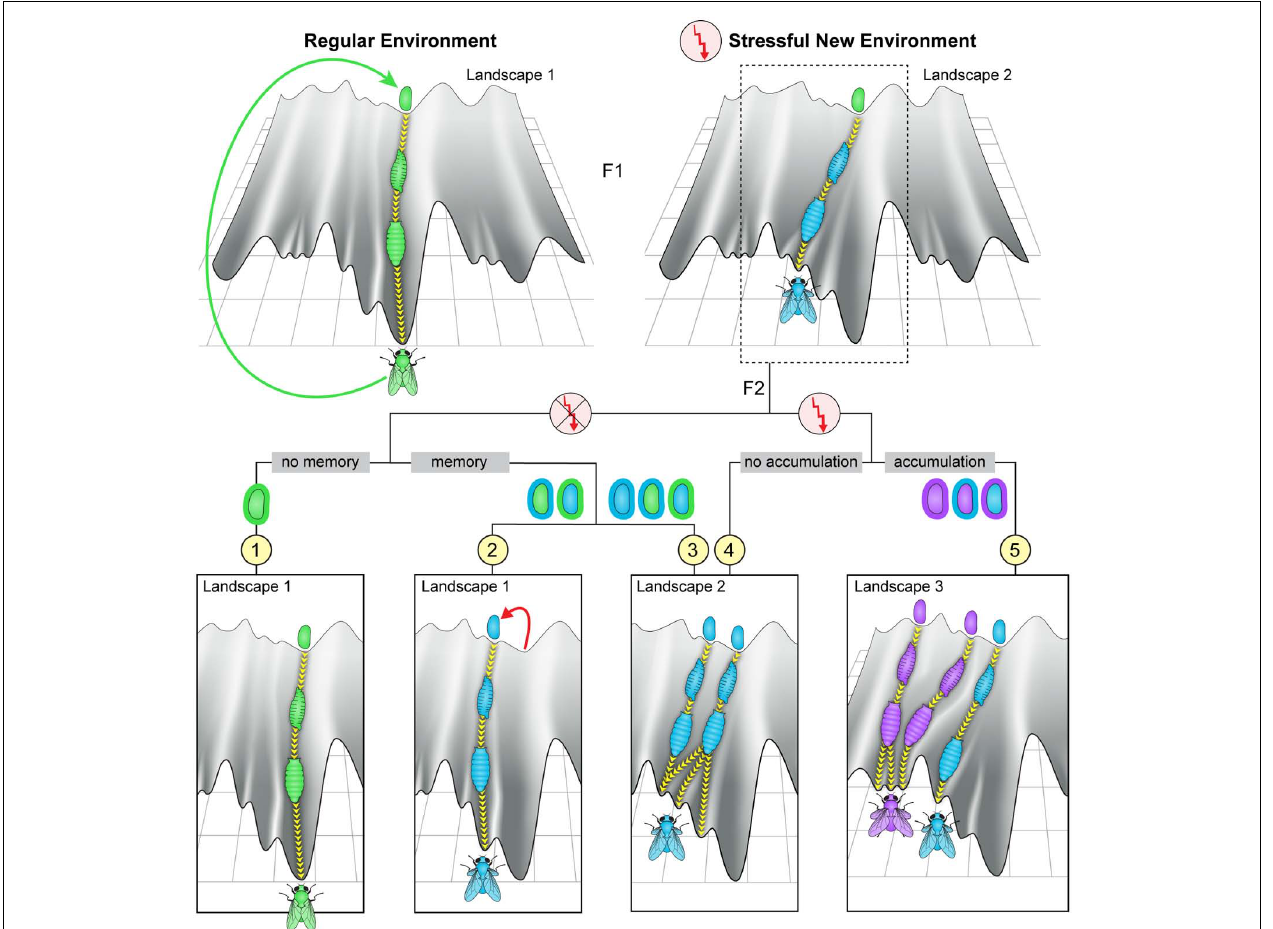
egg are modified following the parental exposure (“memory”), the development of the offspring may differ from their parents even if the external environmental reverts to normal already during the parental generation. In these cases, alteration in offspring development might reflect localization to a different canal in the original or in a modified landscape (scenarios 2 and 3, left trajectory), or localization to a canal that has been modified by the impact of having modifications in the fertilized egg and/or the microbiome (scenario 3, right trajectory). Scenarios (4 and 5): if the external environmental stress persists beyond the parental generation it may again lead to changes in the entry point and shape of the canal (“no accumulation,” scenario 4) as well as further modify the entry point and shape (“accumulation,” scenario